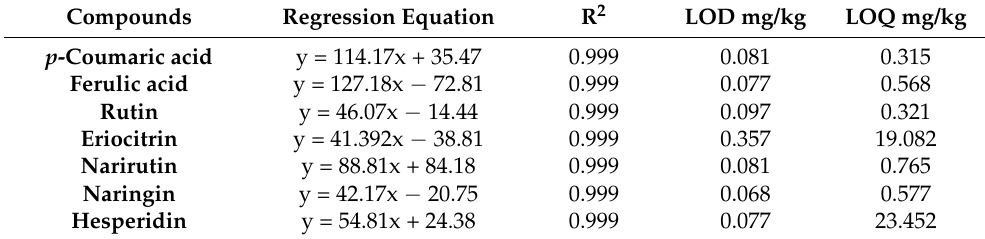
Table 1. Validation methods by UHPLC.